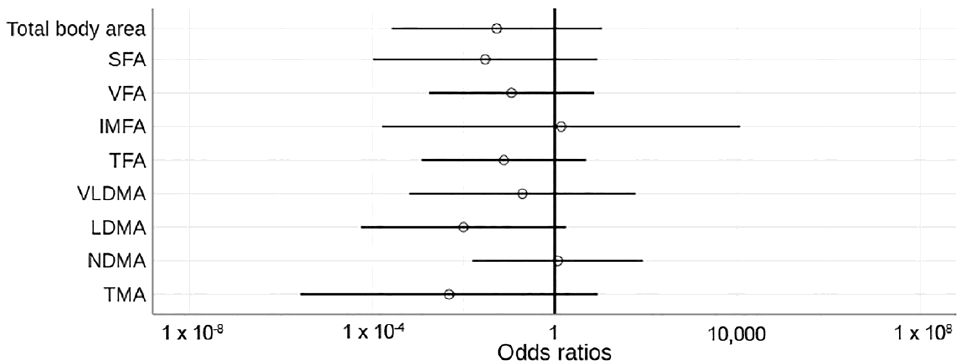
Figure 3. Odd ratios of body composition measures and their relationships with overall mortality. Unfilled figures indicate non-significant values. Vertical black line highlights odd ratio = 1. Confound- ing factors in the model: age, metastases, ECOG (Eastern Cooperative Oncology Group performance status), lactate dehydrogenase (LDH), albumin and urea. SFA, subcutaneous fat area; VFA, visceral fat area; IMFA, intermuscular fat area; TFA, total fat area; VLDMA, very low-density muscle area; LD, low-density muscle area; NDMA, normal-density muscle area; TMA, total muscle